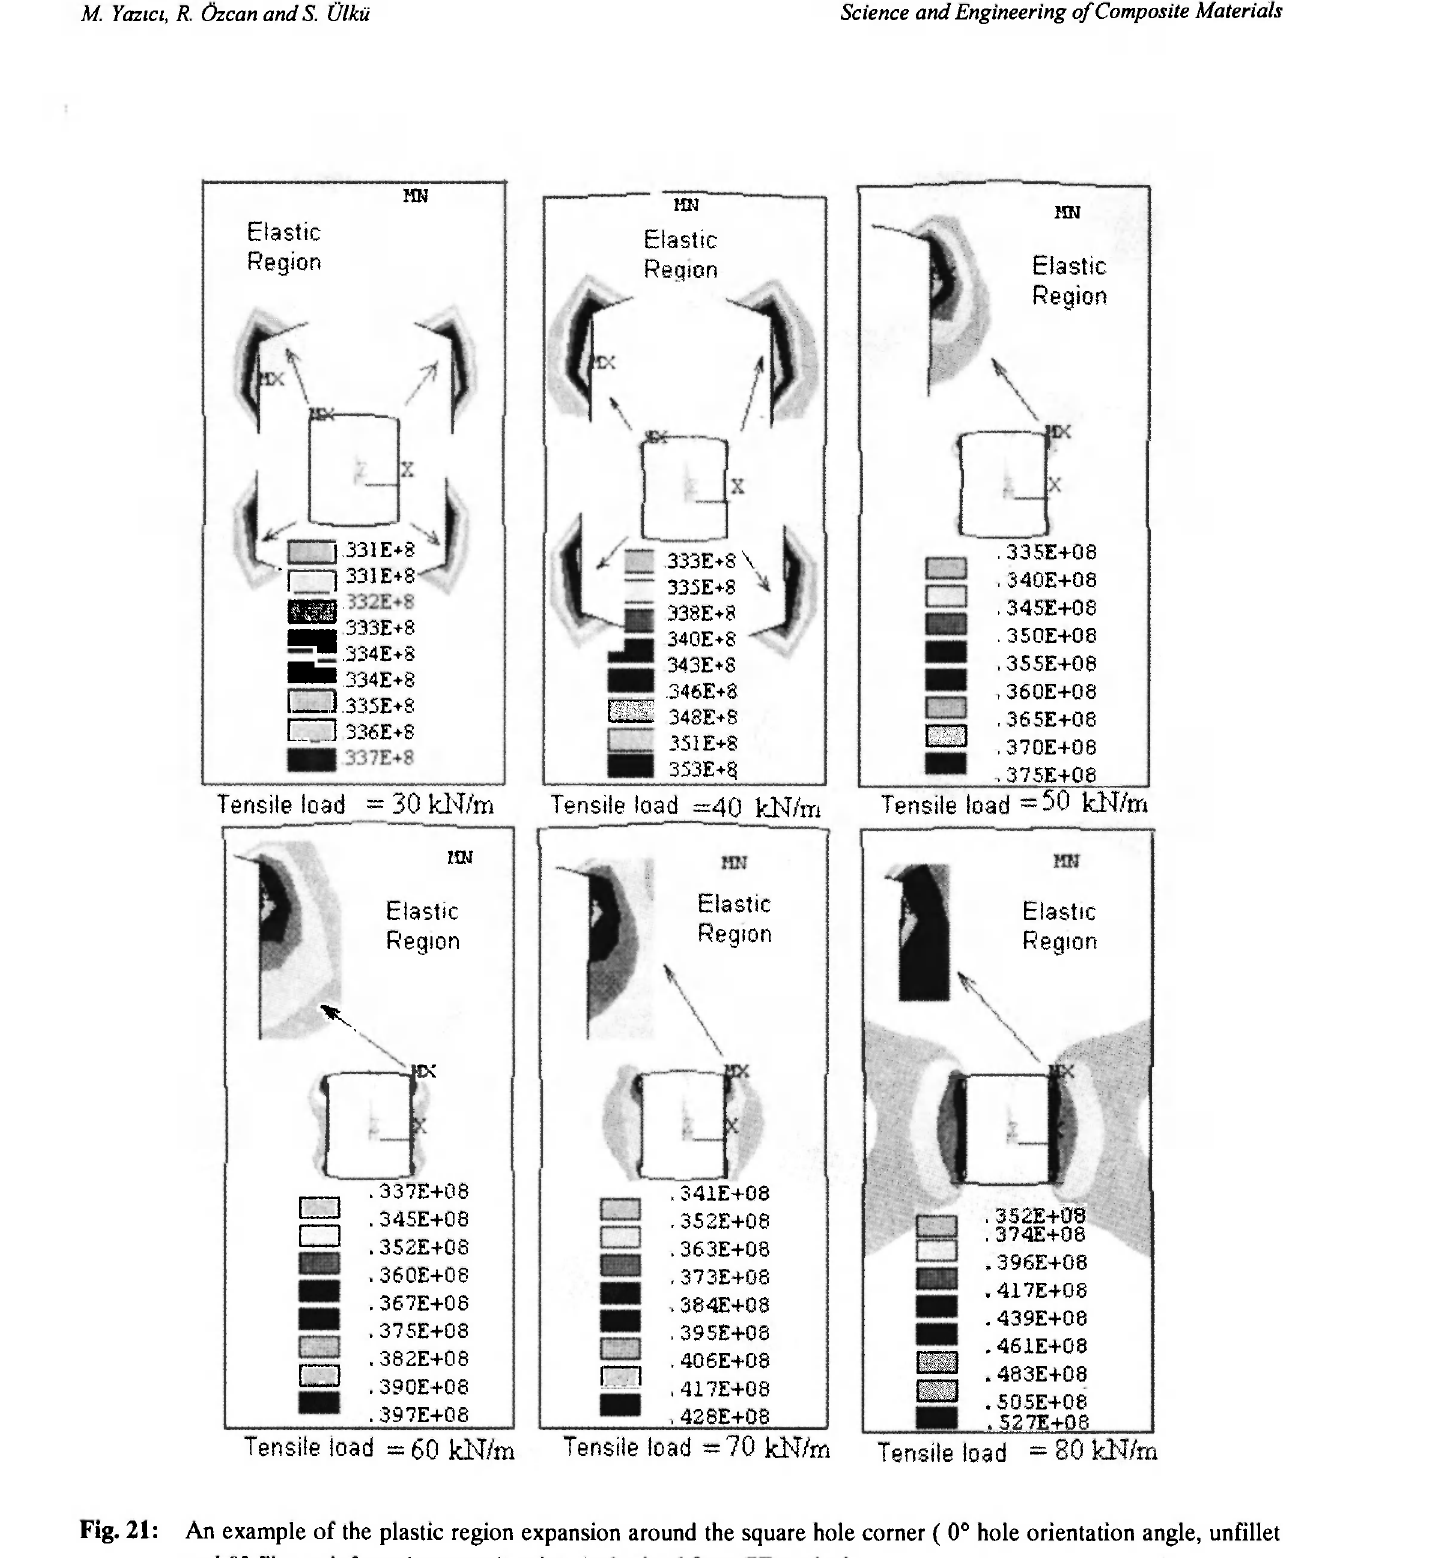
Fig. 21: An example of the plastic region expansion around the square hole corner ( 0° hole orientation angle, unfillet and 0° fibre reinforced composite plates) obtained from FE